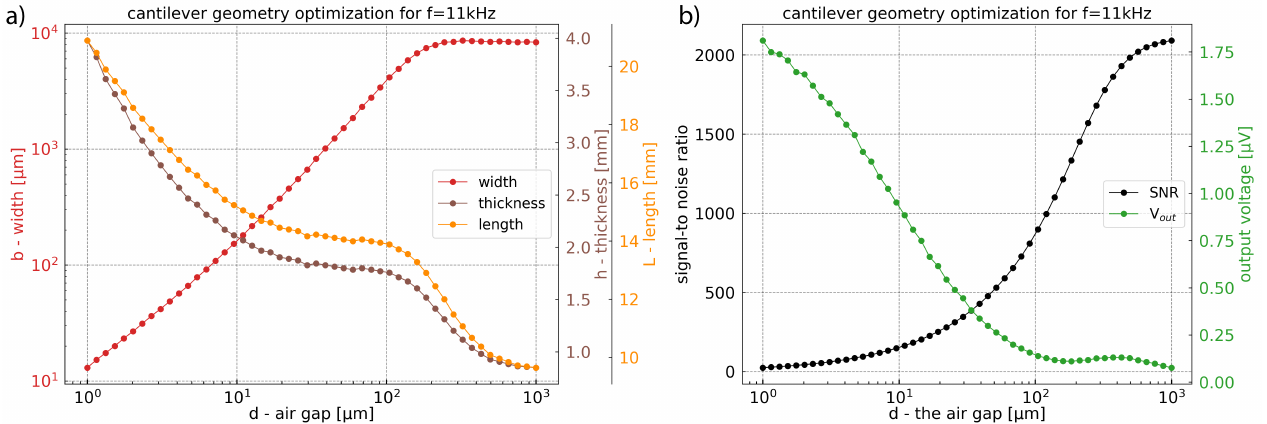
Figure 11. ( a ) Geometrical values giving the highest signal-to-noise ratio as a function of the gap d between support and cantilever. ( b ) Highest signal-to-noise ratio and its corresponding output amplitude signal as a function of the gap d between support and cantilever. For these simulations, the cantilever fundamental resonance frequency is equal to 11